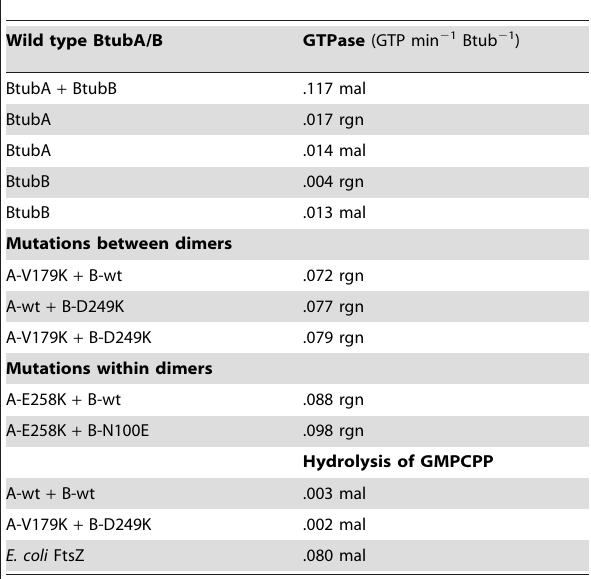
Table 1. GTPase activity